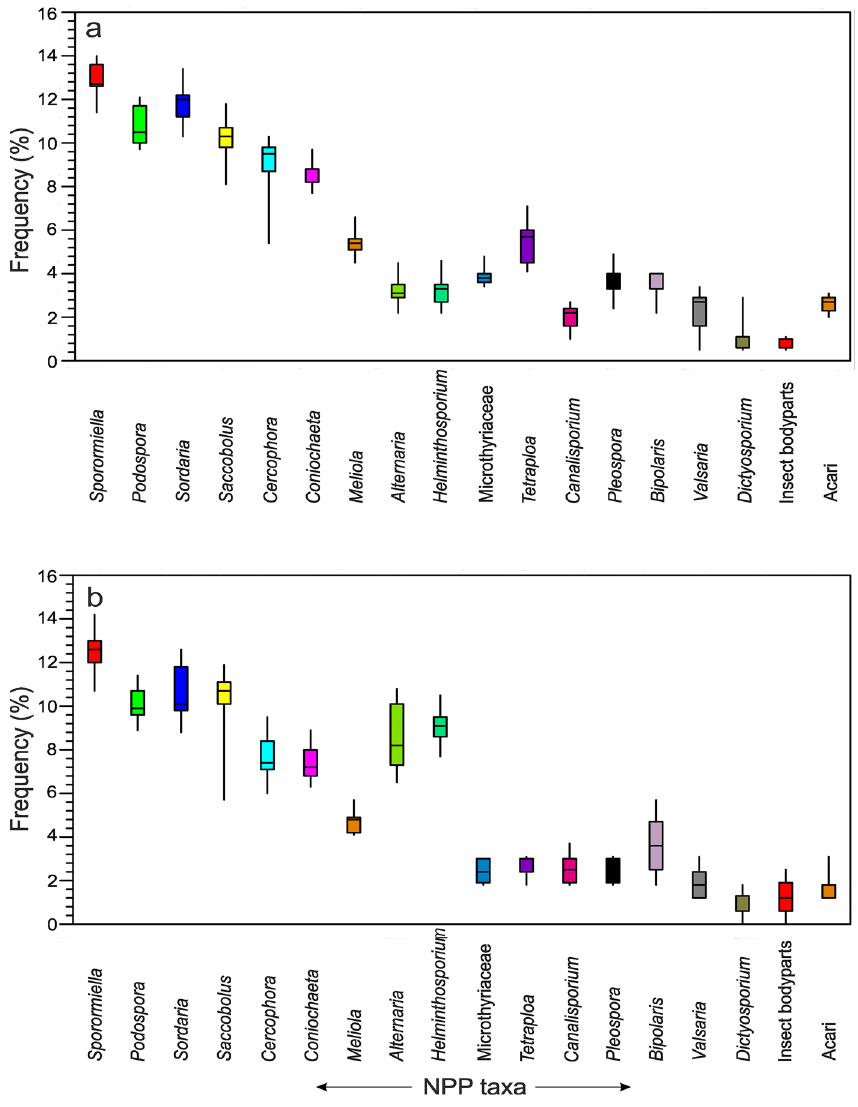
Figure 4. Box plots showing distribution of different NPP taxa in summer ( a) and winter feces ( b)